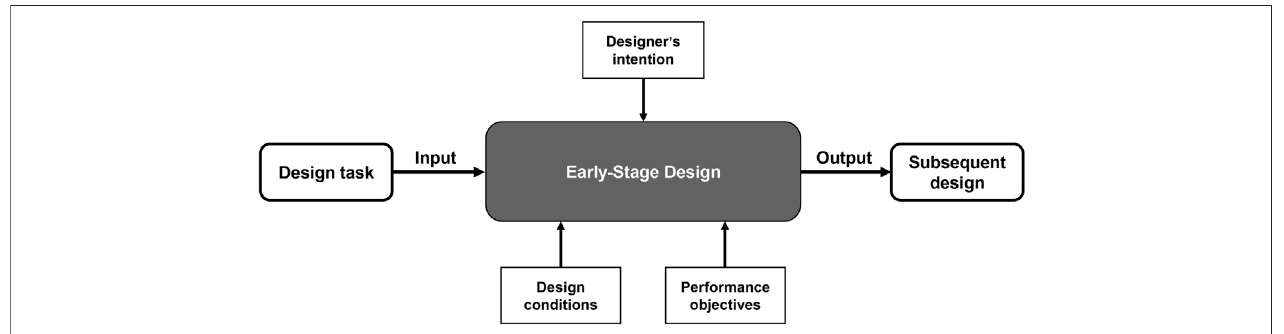
FIGURE 1 | The traditional black box design